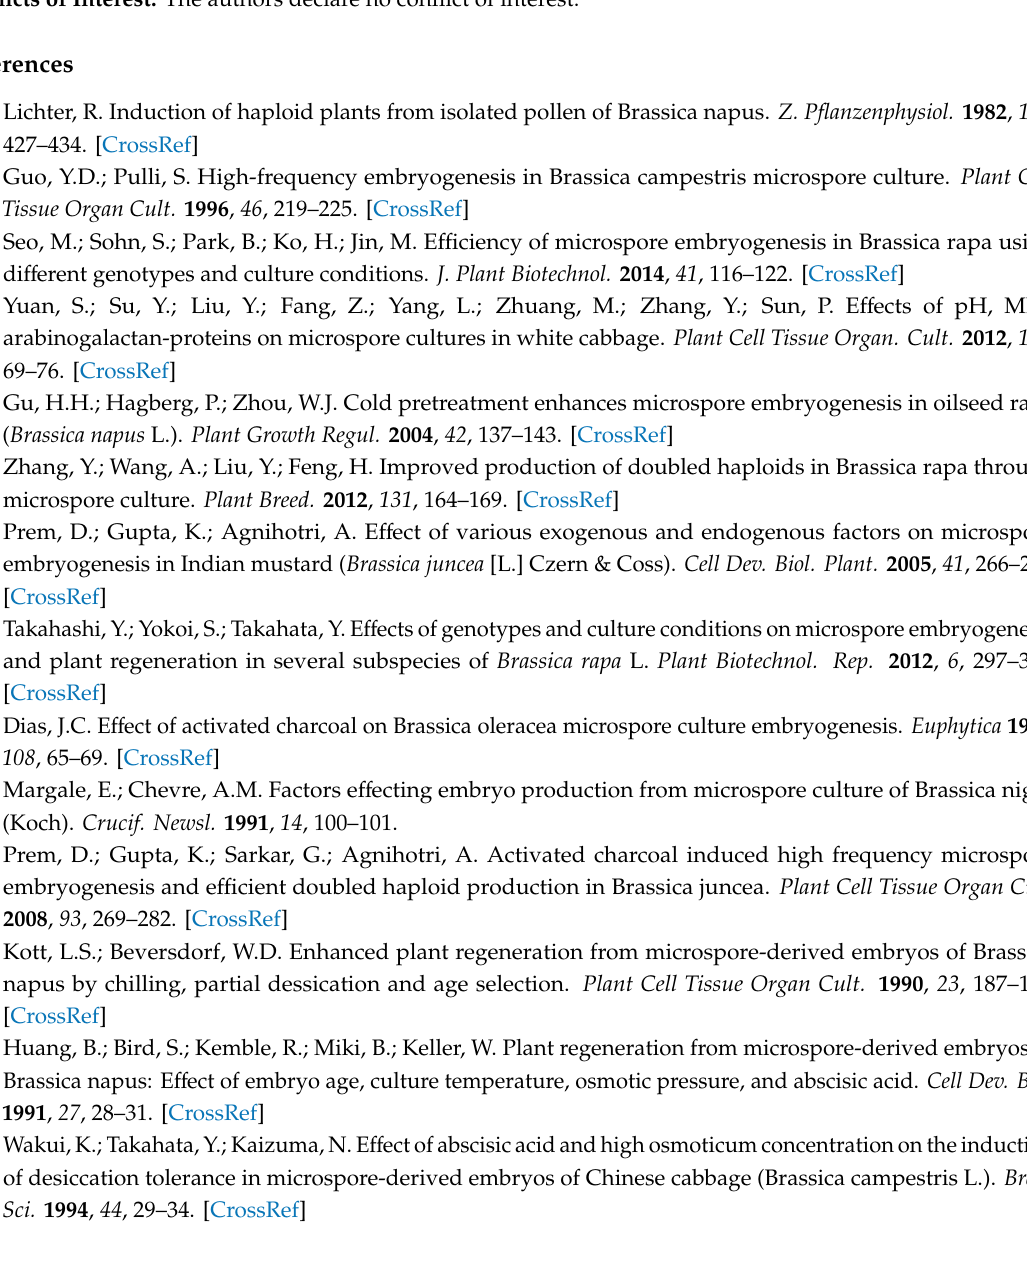
Table S1: Influence of acidity of the medium and AC presence on the development of embryo from microspores of the Ronde witte roodkop herfst variety, Table S2: Influence of acidity of the medium and AC presence on the development of embryo from microspores of the Snow ball variety, Table S3: Influence of acidity of the medium and AC presence on the development of embryo from microspores of the York Globe